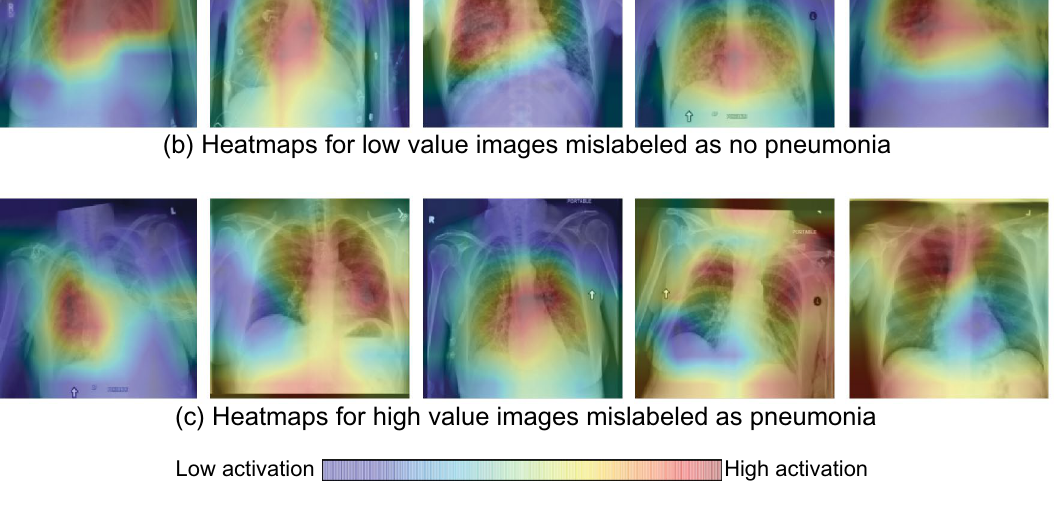
Figure 3. Example heatmaps for ( a ) low value images that were mislabeled as pneumonia, ( b ) low value images that were mislabeled as no pneumonia, ( c ) high value images that were mislabeled as pneumonia. ( a ) Heatmaps show low activations in relevant areas in the lung but high activations in irrelevant areas outside the lung, suggesting that the input feature vectors favored no pneumonia over pneumonia. ( b ) Heatmaps show high activations in lung areas indicating pneumonia, suggesting that the input feature vectors favored pneumonia over no pneumonia. ( c ) Heatmaps show high activations in abnormal lung areas. The first three images show abnormal opacity. The fourth image shows interstitial patterns, predominantly in the upper lung fields. The last image shows abnormal mass in the upper right lung field (i.e. upper left of the image).